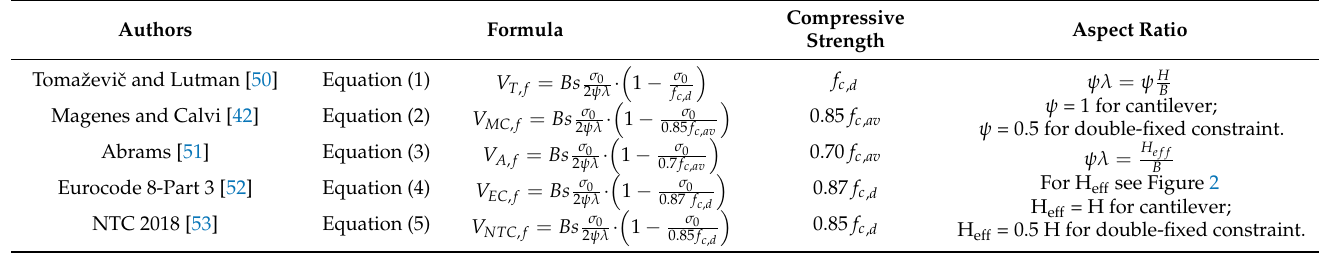
Table 1. Literature formulations used to predict the flexural capacity.